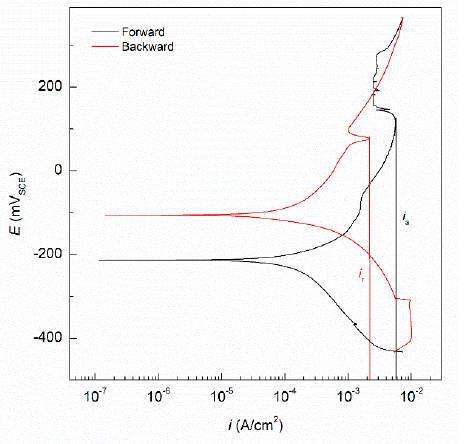
Figure 4. DL − EPR plot for Inconel 718 treated with UNSM × 3, sample